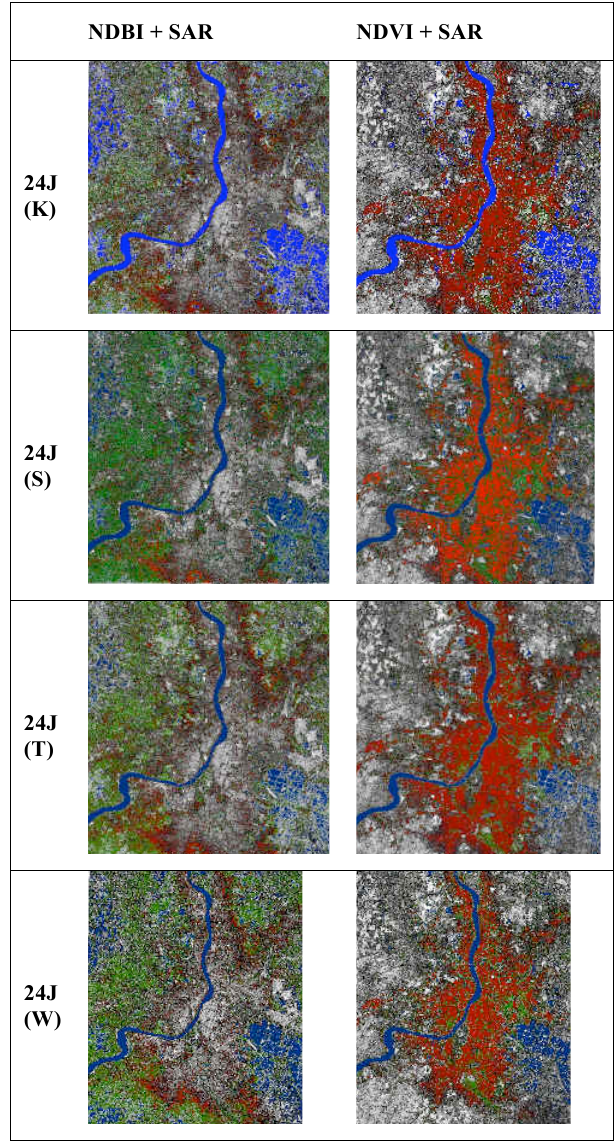
Figure 3: Combination of NDBI and NDVI with Sentinel-1 data classified images; 24J: 24th July; (K): K-Means clustering; (S): Supervised classification; (T): Texture image; (W): Wishart H-A-Alpha classification